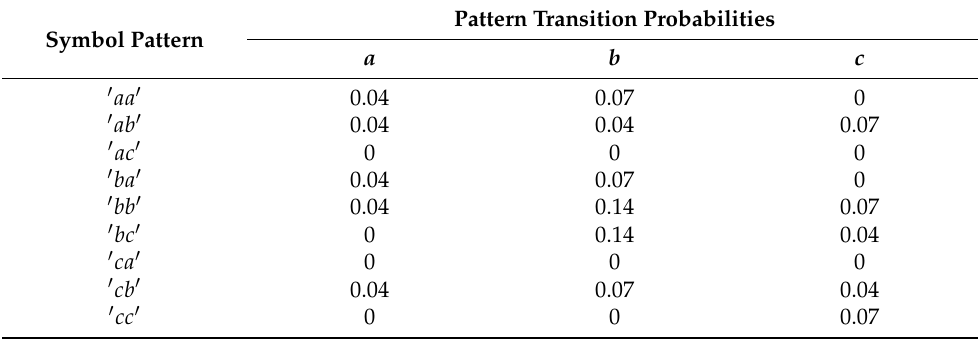
Table 1. An example of pattern transition probability P computed from co-occurrence pattern transition matrix M with word size W = 3 for the symbolic sequence D